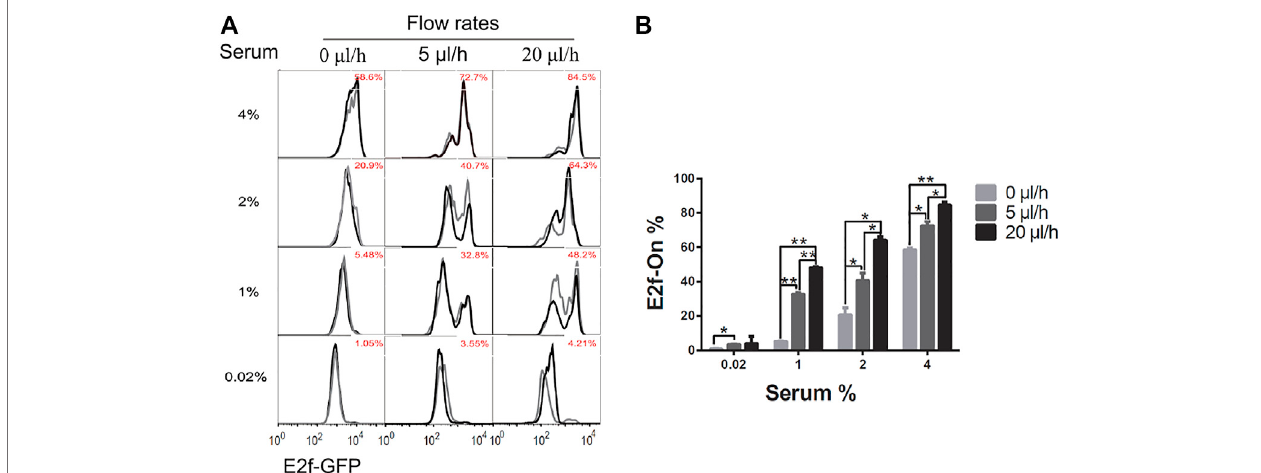
FIGURE 3 | Higher extracellular medium fl ow rates lead to shallower quiescence. REF/E23 cells seeded in micro fl uidic devices were induced to and maintained in quiescence by culturing them in serum-starvation medium for 4 days under various medium fl ow rates as indicated. Cells were then stimulated with serum at the indicated concentrations for 26 h, and the E2f-GFP signals were measured using fl ow cytometry. (A) The E2f-GFP histograms. Numbers in red indicate the average percentages of cells with E2f-GFP at the “ On ” state (see Supplementary Figure S1D for examples) based on duplicate samples (black and grey histograms). (B) StatisticbarchartoftheE2f-On%incellpopulations(fromA)asafunctionofmedium fl owrate(inserum-starvation)andserumconcentration(inserum-stimulation).Error bars, SEM ( n = 2), * p < 0.05, ** p < 0.01 (1-tailed t-test; the same